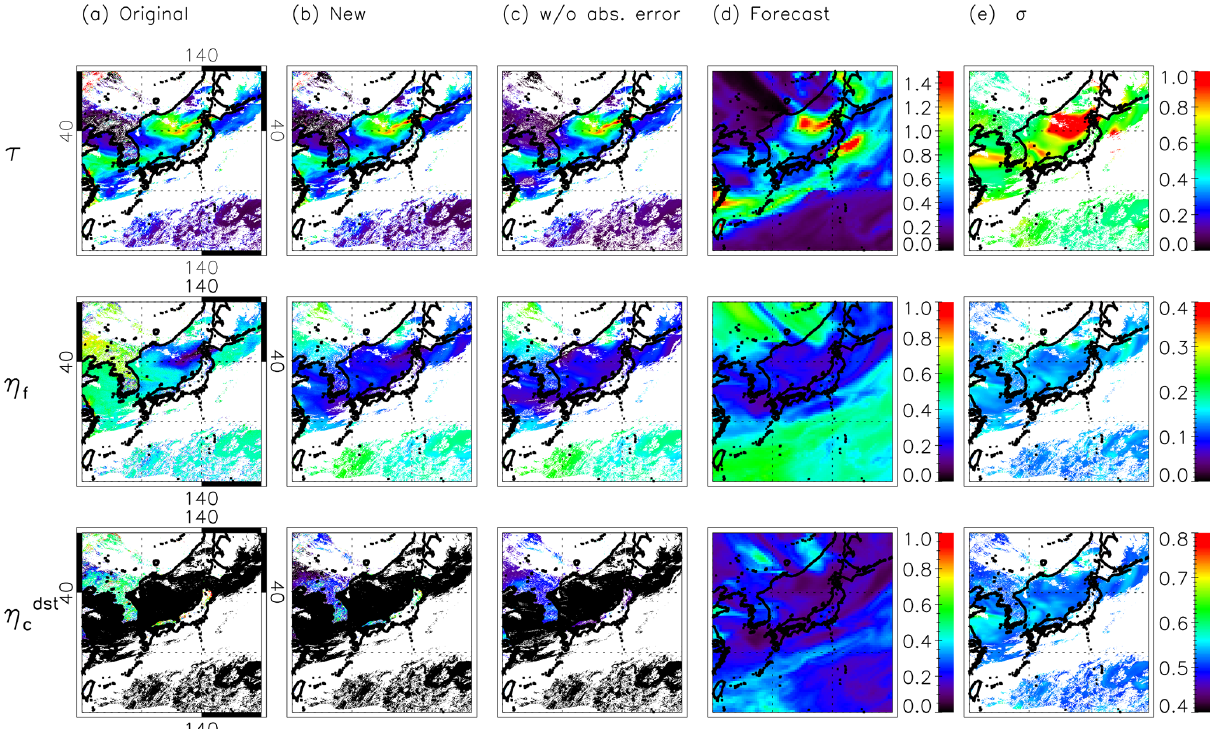
Figure 5. Same as Fig. 4, except for the case at 05:00UTC on 7 May